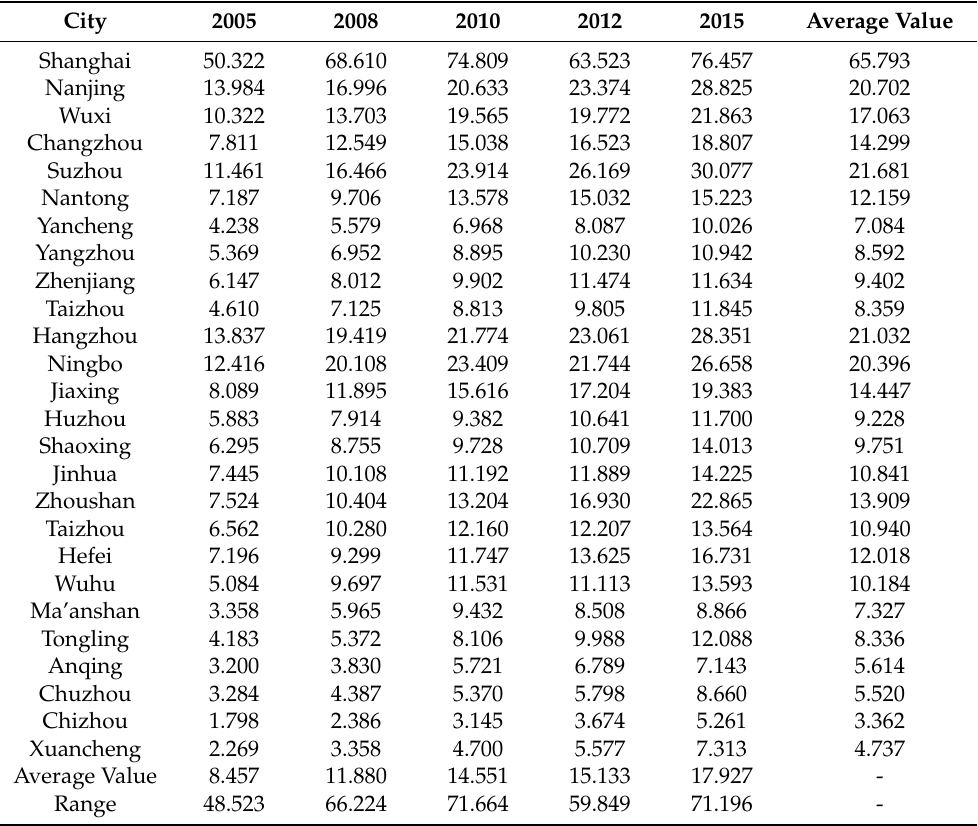
Table 2. The score F t of the development level of the logistics i